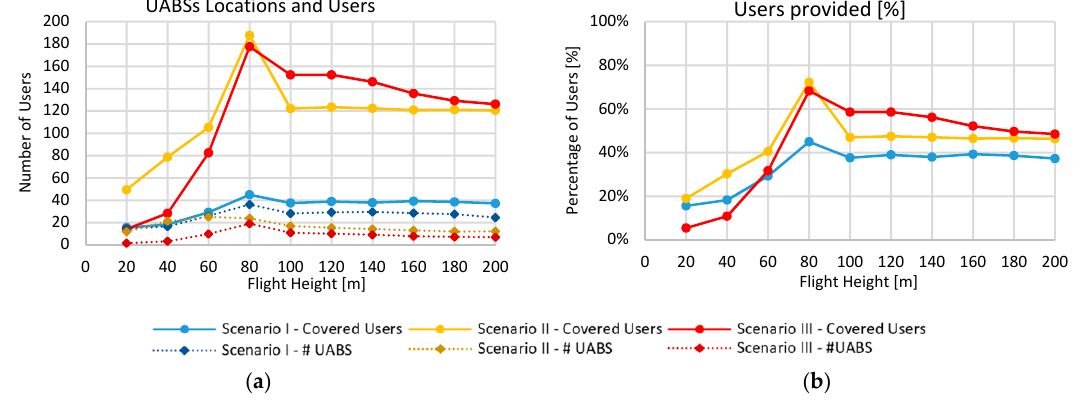
Figure 6. Comparison of network performance in different flight heights. ( a ) Number of users and number of UABS. ( b ) Percentage of served users.